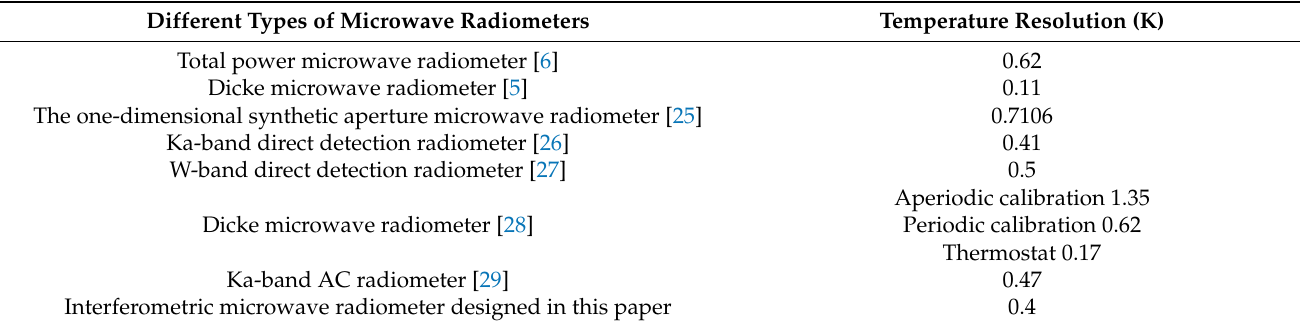
Table 3. The comparison of temperature resolution of different types of microwave radiometers. Different Types of Microwave